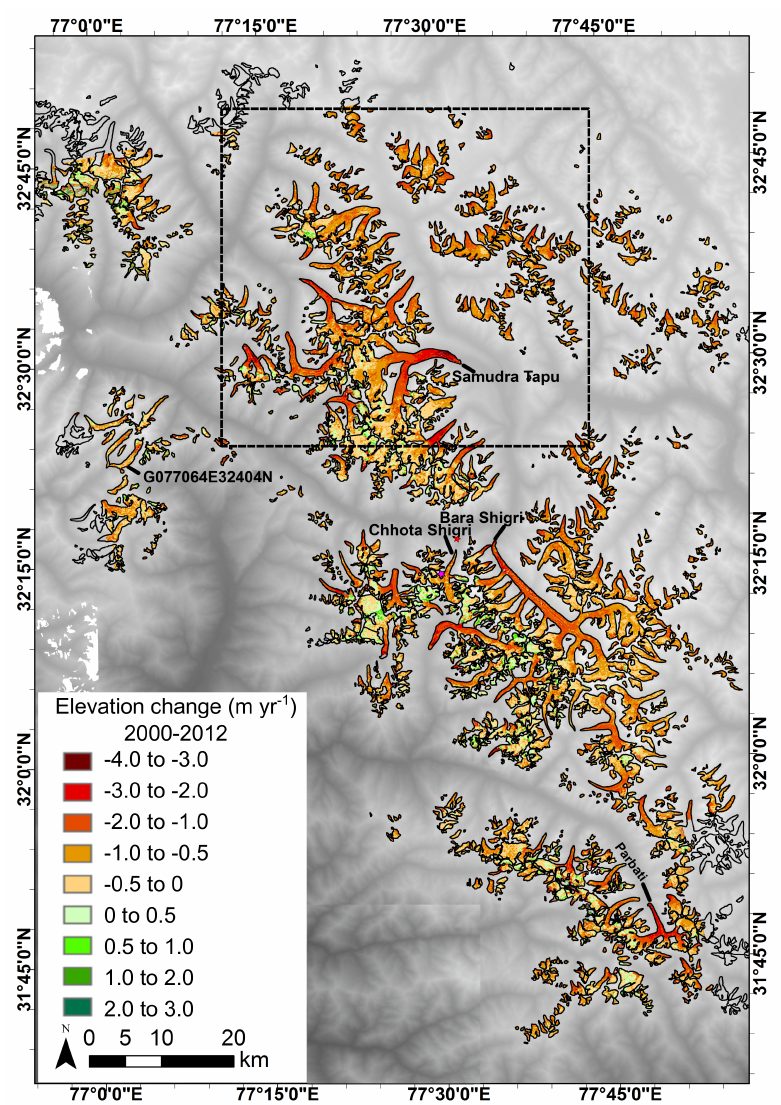
Figure 3. Map of elevation changes of glaciers in the Lahaul-Spiti region between February 2000 and Januray–February 2012. The black dotted rectangle indicates the area where SRTM C- and X- band penetration difference was